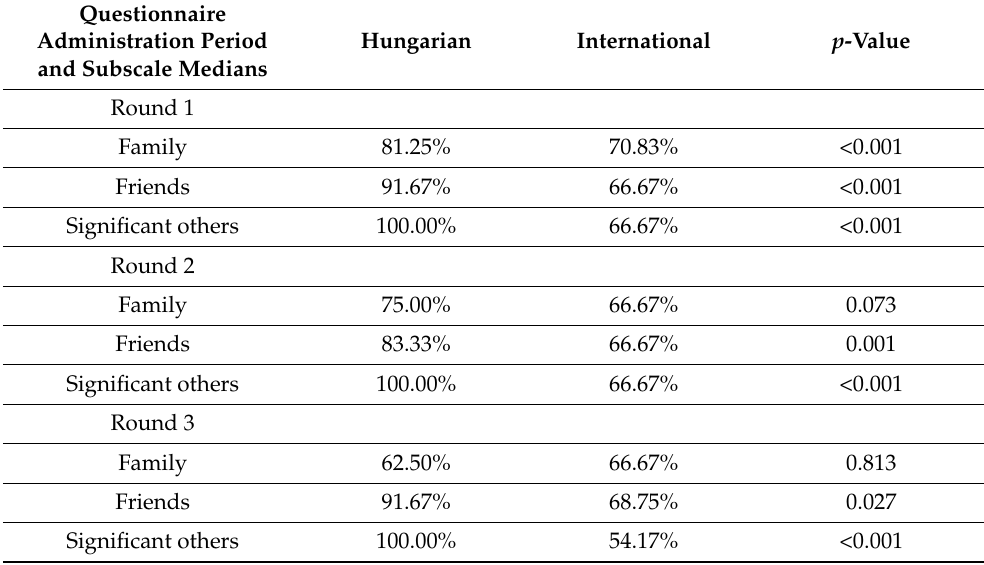
Table 4. Differences in perceived social support subscales among the domestic and international students.